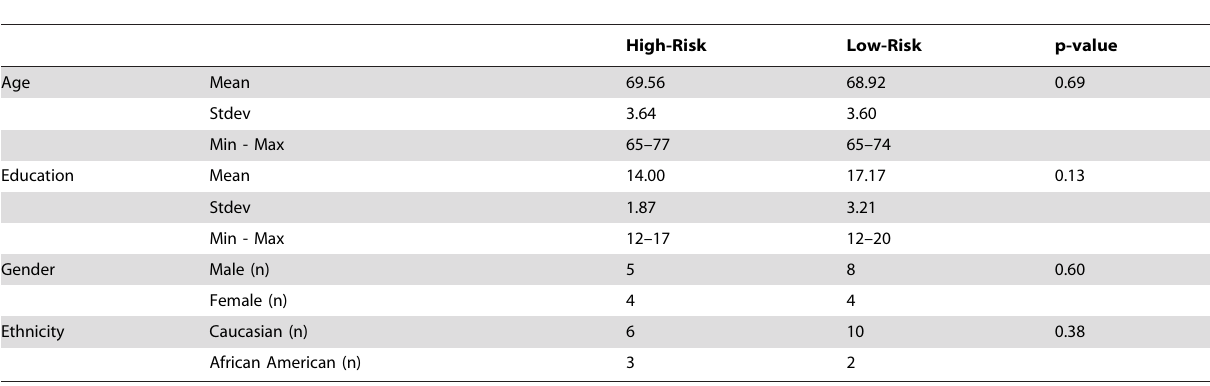
Statistics for categorical variables (race, gender and education) were assessed with a Pearson’s Chi Squared test. Statistics for continuous variables (age) were assessed with ANOVA. P-values are reported. Additionally, a Pearson’s chi-squared test comparing training group by risk category showed an insignificant difference p=0.823, meaning the training groups included equivalent numbers of each risk category.